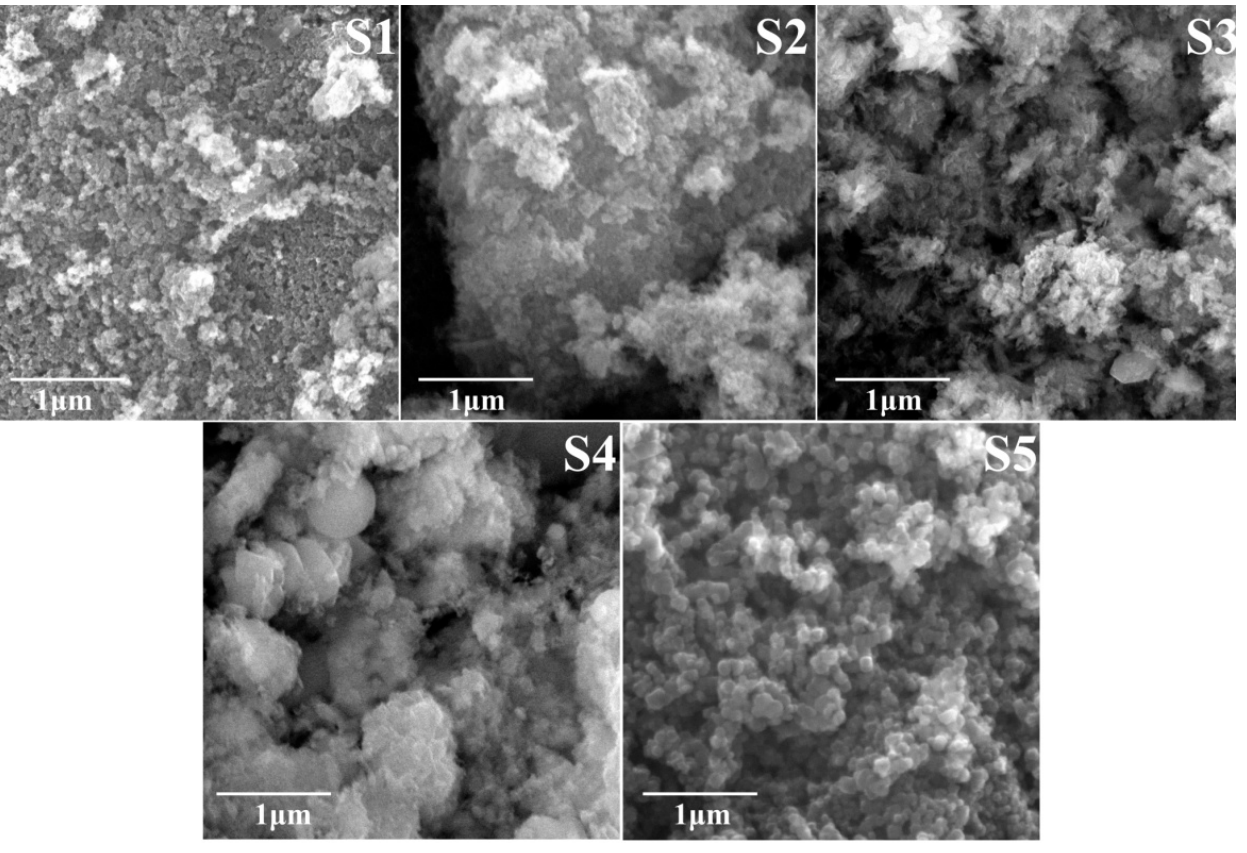
Figure 4. SEM images of synthesized powders. Table 3. The size of particles